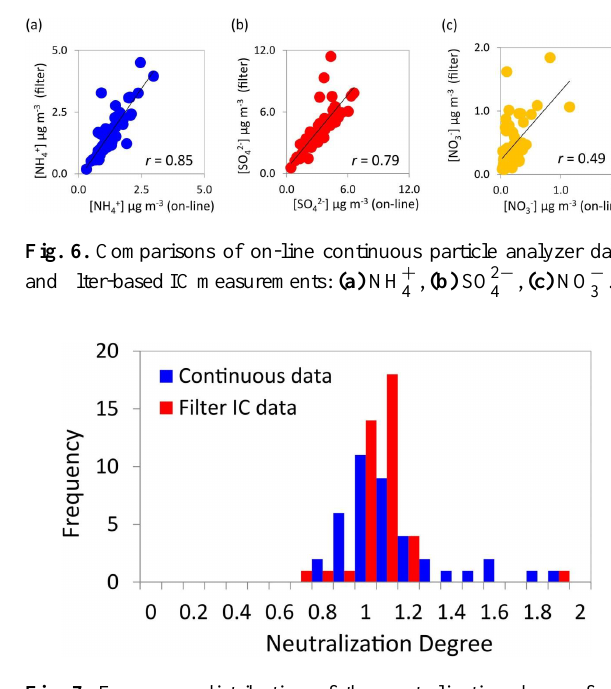
Fig. 7. Frequency distribution of the neutralization degree from Figure 7. Frequency distribution of the neutralization degree from aerosol samples calculated by 689 aerosol samples calculated by on-line continuous particle analyzer on-line continuous particle analyzer data (blue) and filter-based IC data (red). 690 data (blue) and filter-based IC data